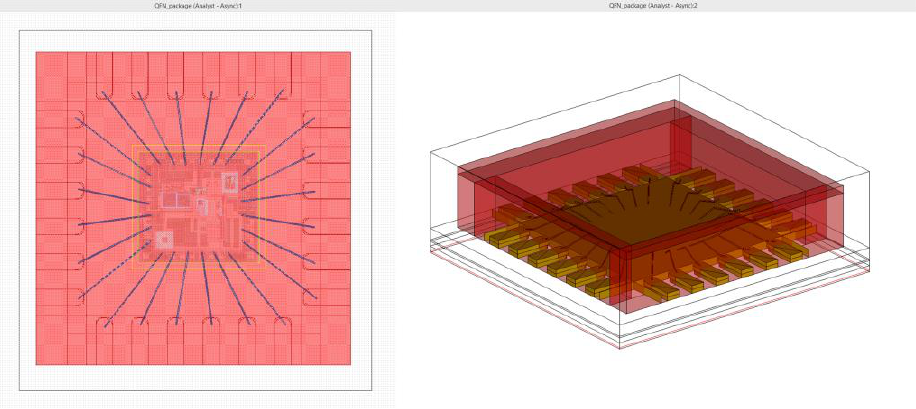
Fig. 3. Core Chip packaging EM simulation.